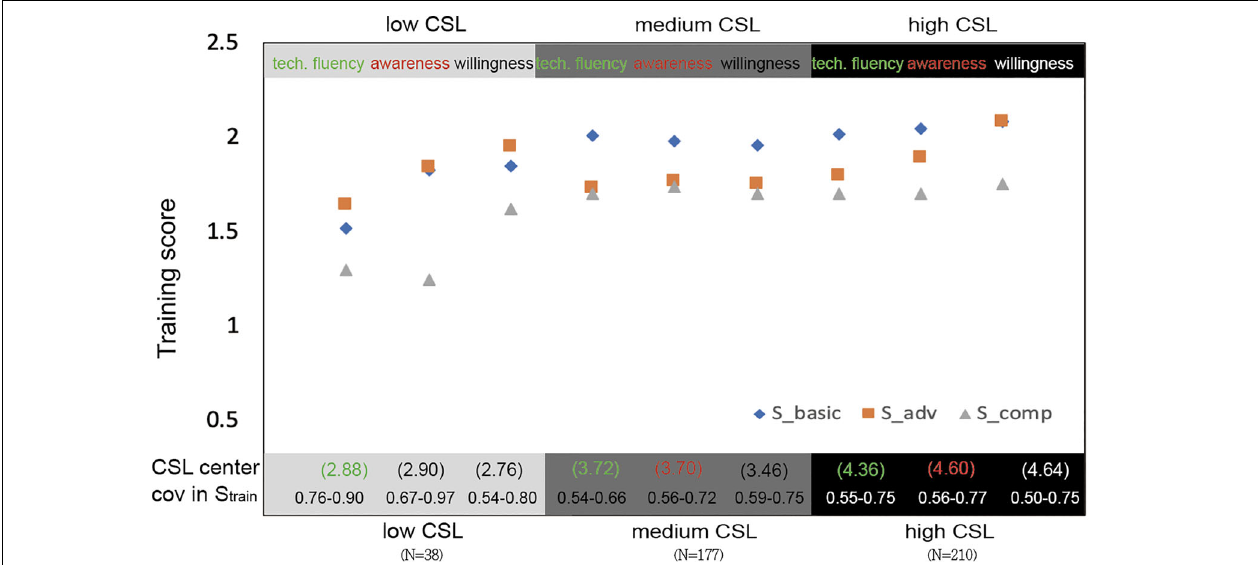
FIGURE 8 | The relationship between the training scores and CSL. Low, medium, and high CSL is now divided into three dimensions (Technology fluency, awareness, and willingness), to correlate with training score. The number of samples that belong to groups of low, medium, and high CSL is 38, 177, and 210, respectively. In the bottom, the numbers in the first row (within the brackets) denote the clusters center for individual CSL group using k-means. The numbers in the second row denote the range of coefficient of variation in Sbasic, Sadv, and Scomp.